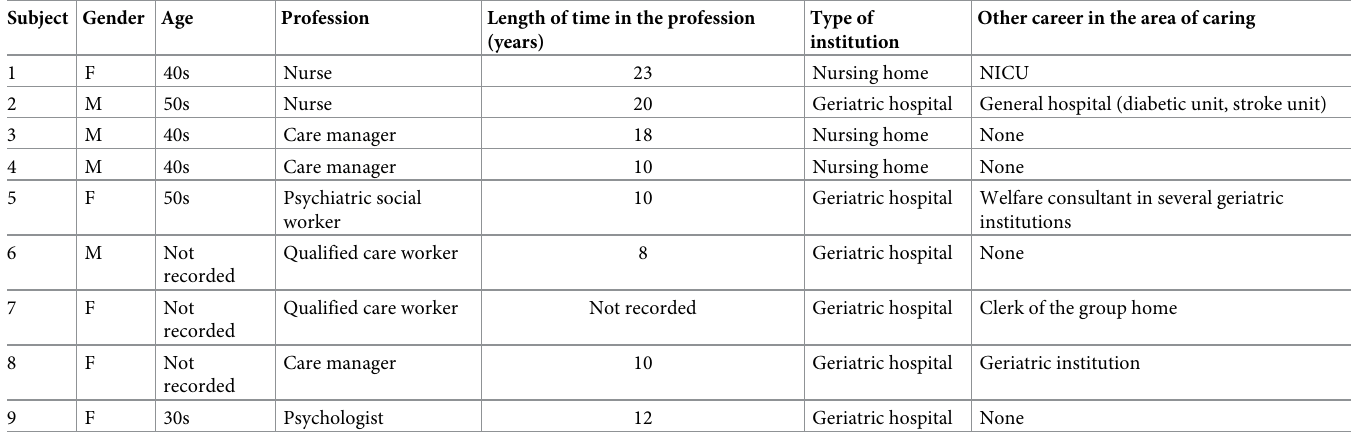
Table 2. Characteristics of interviewees.